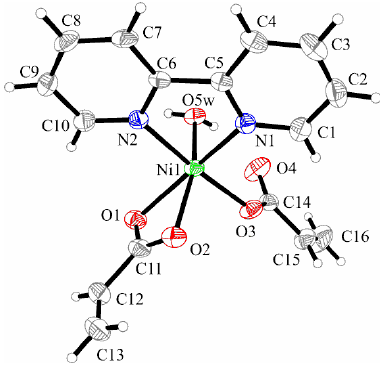
Figure 3. X-ray structure of [Ni(2,2 ′ -bipy)(C 3 H 3 O 2 ) 2 (H 2 O)] ( 2 ). Thermal ellipsoids are shown with 30% probability.